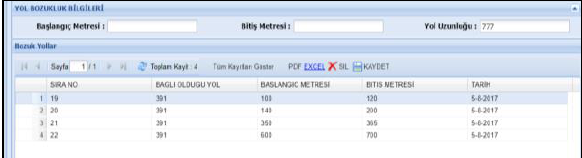
Figure 13. Getting length of selected road with PostGIS Spatial Function